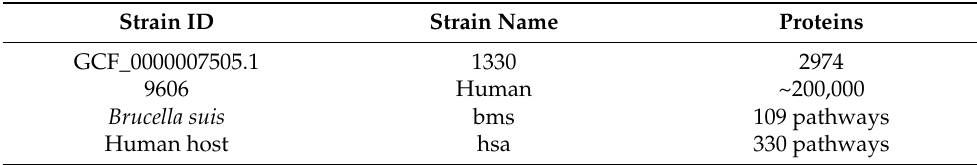
Table 7. Complete Proteome of Human-Host and Brucella suis